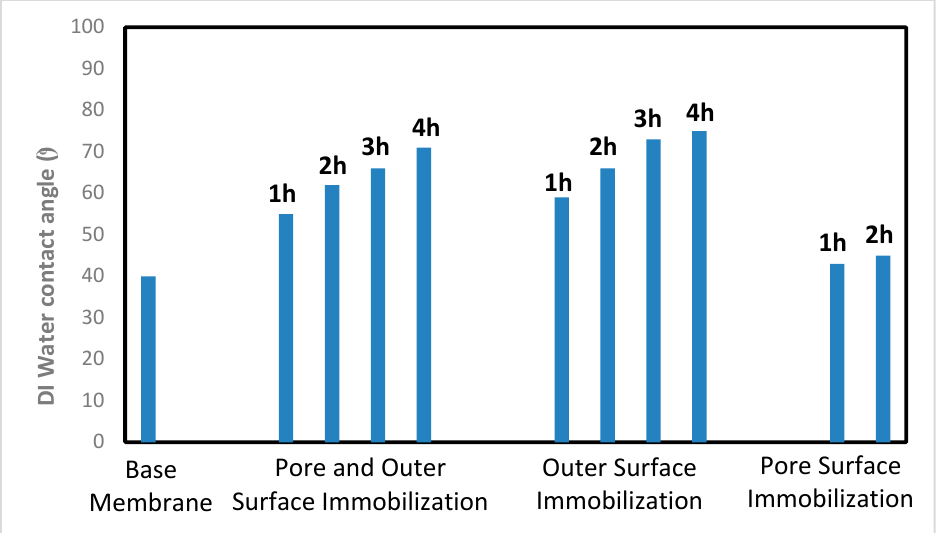
Figure 2. DI water contact angle for the base membrane and membranes modified using the three initiator immobilization strategies. Results are shown for the different polymerization times investigated and represent the average of 5 repeat readings with a range of ± 10%.